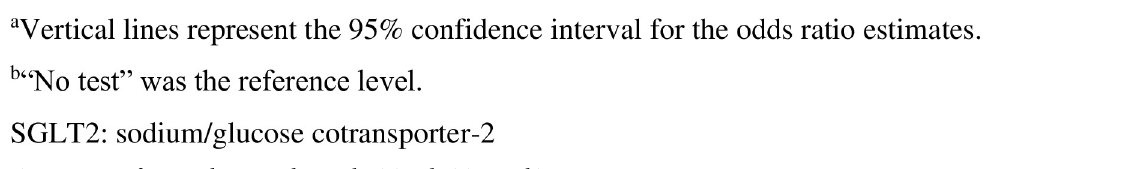
Fig 5. Impact of PromarkerD results on physician